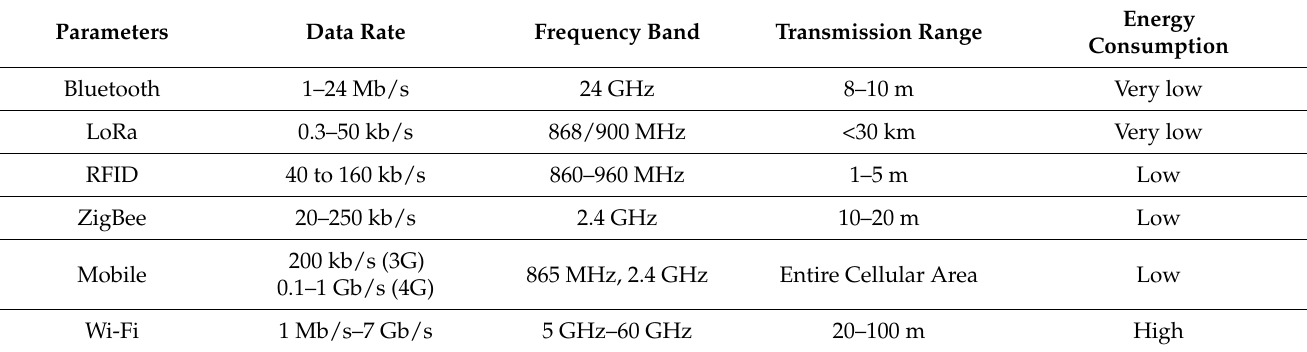
Table 1. Comparison between the technologies used for connectivity in the agricultural